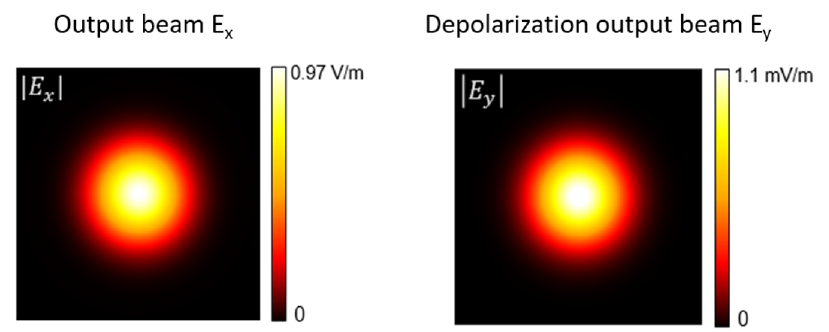
Figure 8. FS mirror output beams for E x and E y (depolarization). The scale in the output signal E y , evidence just a small effect on the beam depolarization from the input beam.